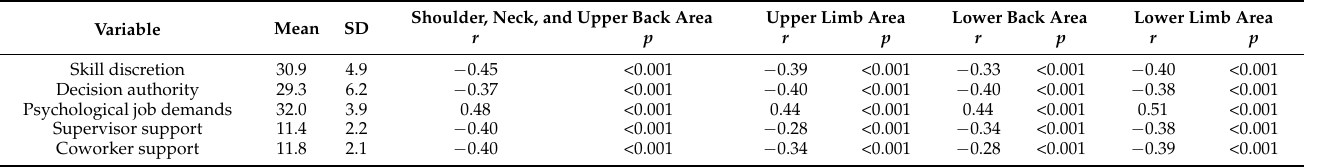
Table 2. Results of the correlation analyses of work-related psychosocial factors and the four MSD areas among nursing aides in LTCFs ( n =